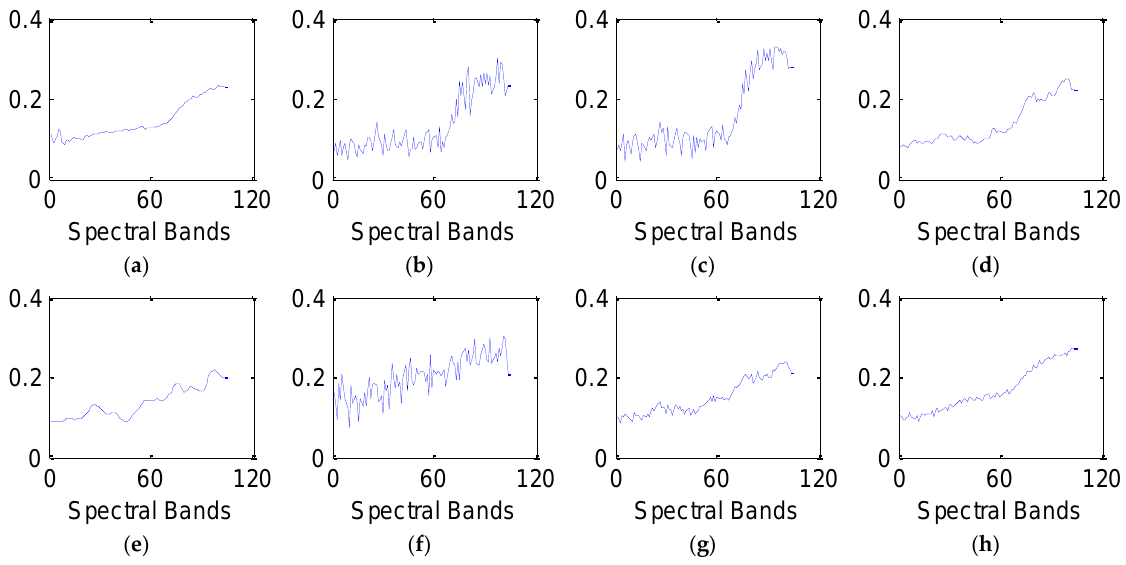
Figure 9. Spectral reflectance curves at pixel (559, 150) before and after denoising: ( a ) clean HSI; ( b ) KSVD; ( c ) BM3D; ( d ) ANLM3D; ( e ) BM4D; ( f ) LRMR; ( g ) DDL3+FT; ( h ) Our method.